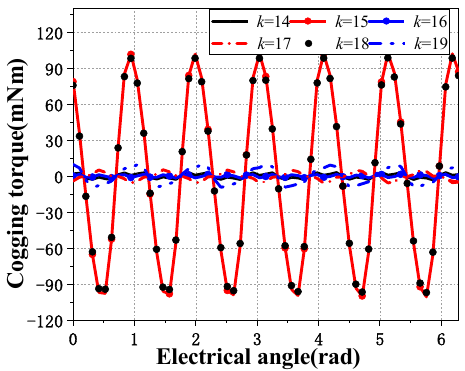
Figure 10. Cogging torque with different tooth pitch by FEM.